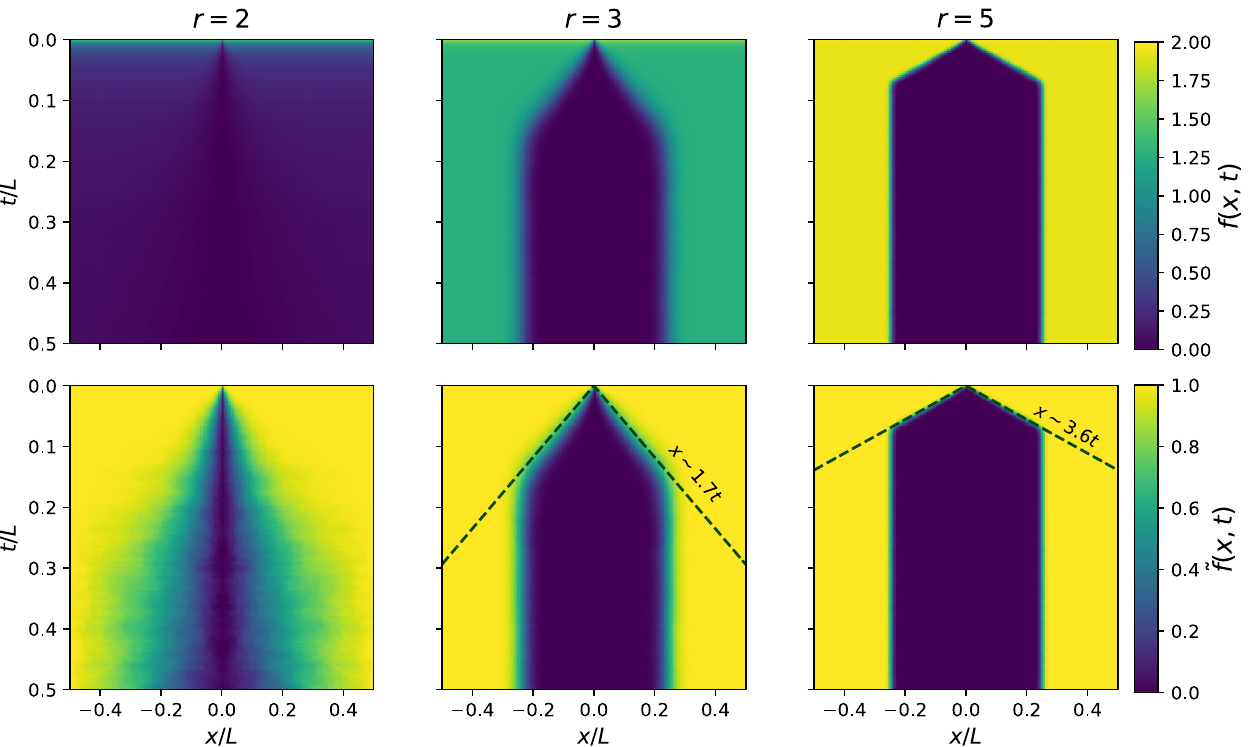
FIG. 11. Information spreading in measurement-only dynamics. Top: f ð x; t Þ as defined in Eq. (11) (mutual information between a 0 ; 1 ; 1 ; 1 Þ of range r ¼ 2 (critical), 3, and 5 reference initially entangled at x ¼ 0 and a region ½ − x; x (cid:3) ) for factorizable ensembles q ¼ 1 3 ð (volume-law) for a system of L ¼ 255 qubits. There is a clear ballistic light cone in the volume-law phase. The light cone saturates to ˜ t Þ reveals that information spreading is bounded by a light f ð x; t Þ ¼ f ð x; t Þ = 2 S half the system size. Bottom: The normalized quantity R ð cone in the critical phase as well. The approximate location of the wave front is highlighted with a dashed line in the volume-law t increases with increasing range r examples. The butterfly velocity x ∼ v B